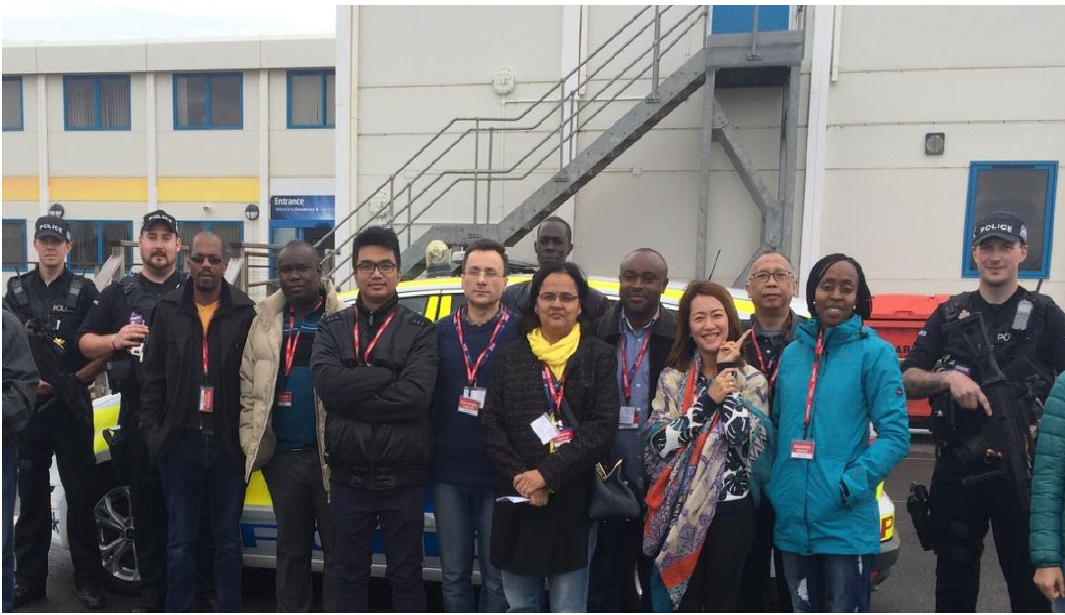
Figure 5. Alpana Goel (center) visiting a nuclear facility during the workshop held at King’s College London in September